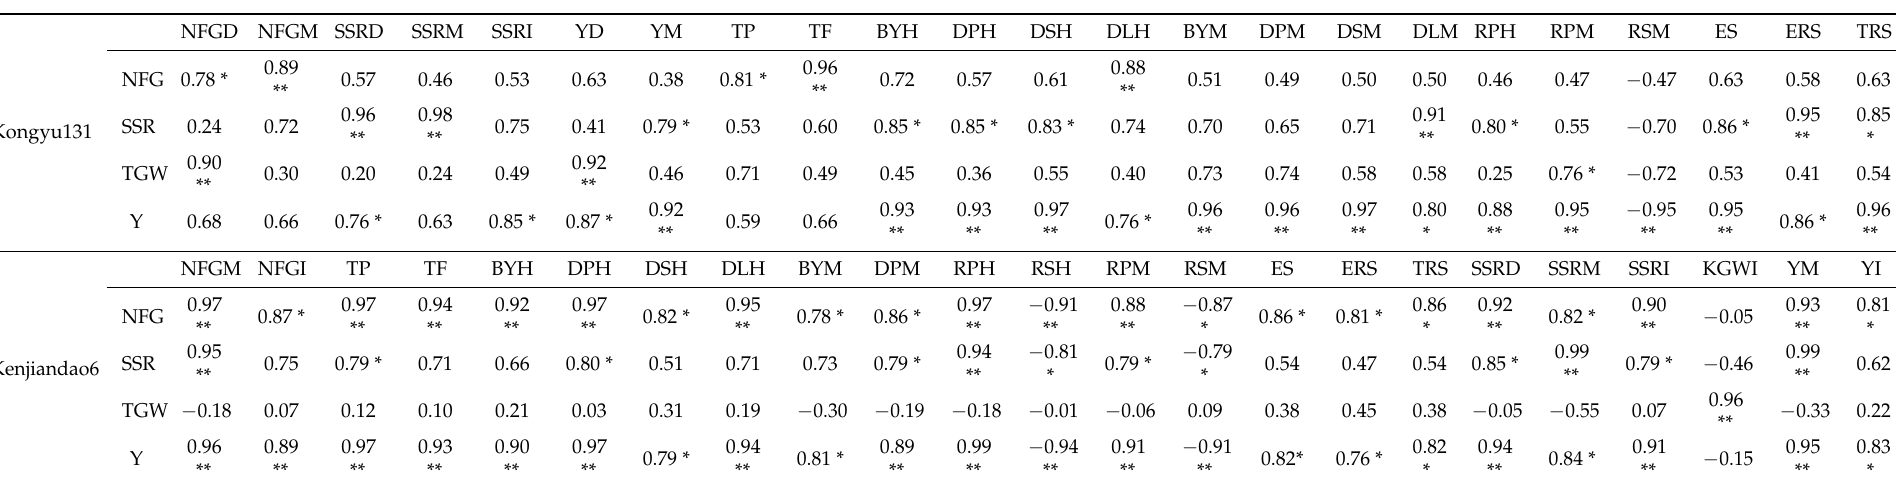
Table 2. Correlations of yield factors and dry matter production after DA-6 treatment in both cultivars under CWS.